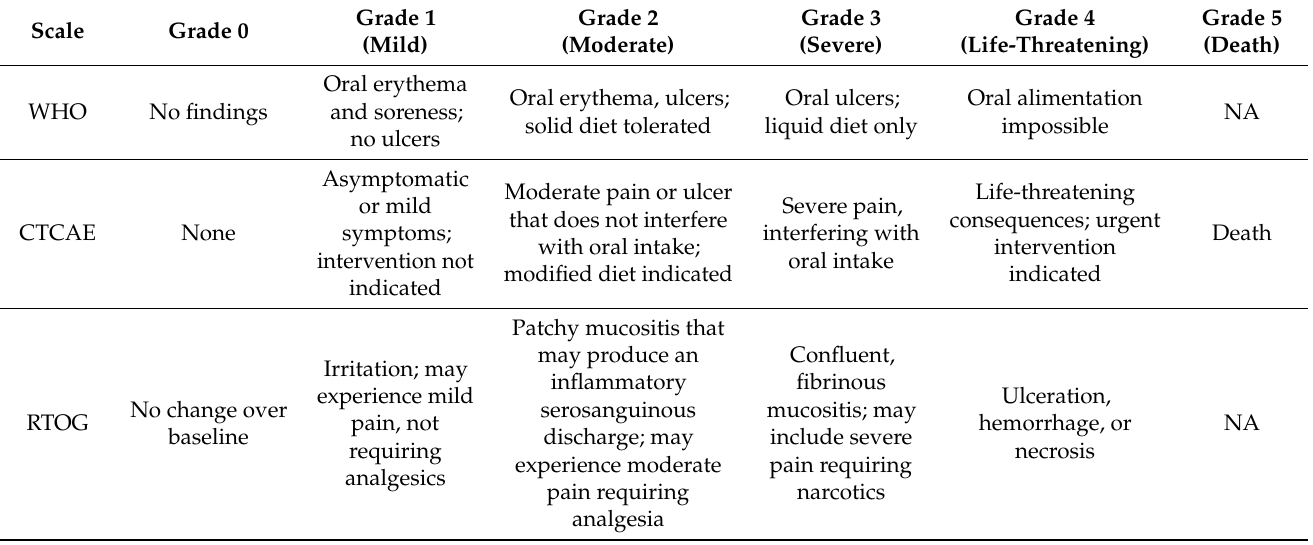
Table 1. Available clinical scales for oral mucositis assessment. Adapted from [16]. NA—Not